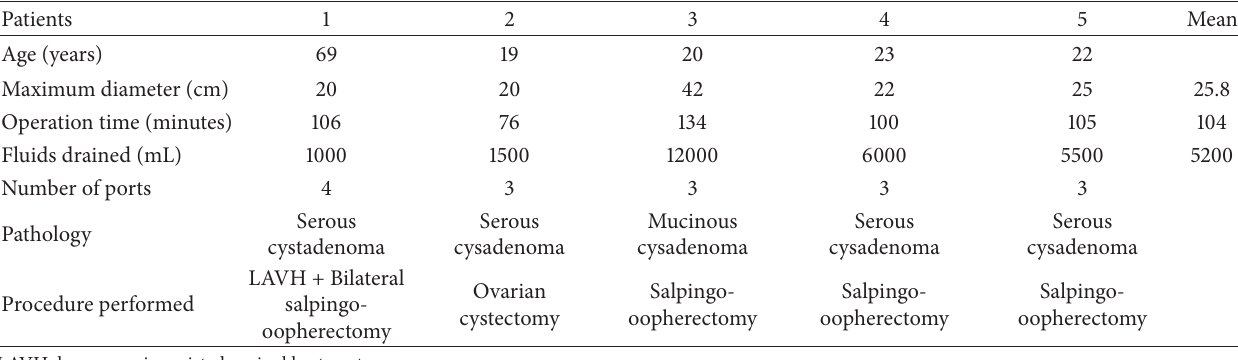
Table 1: Patients’ characteristics and operative details.